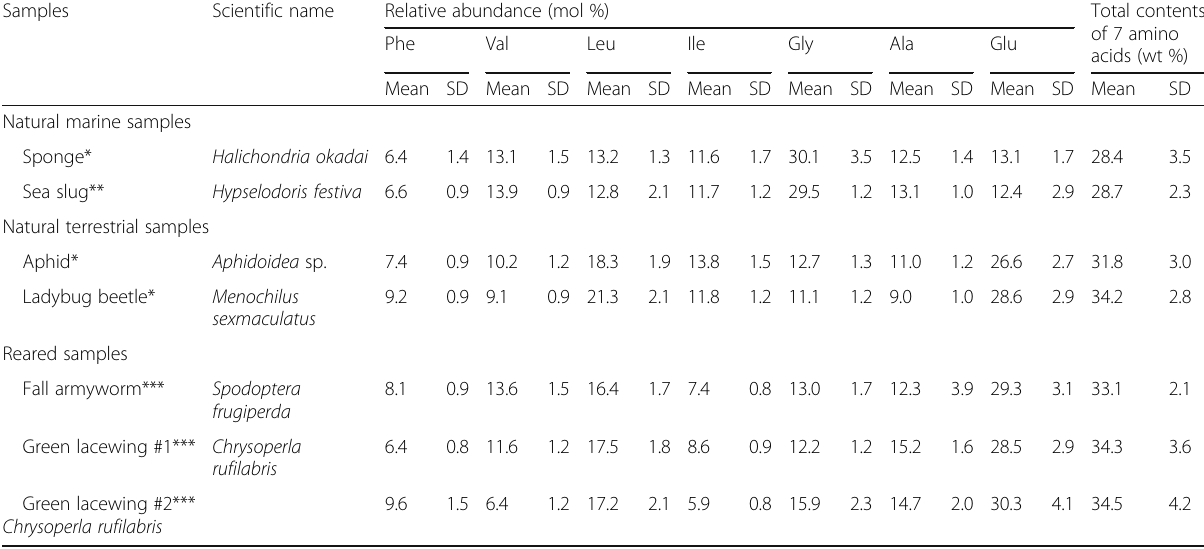
Table 1 Molar balance of amino acids in the combination samples